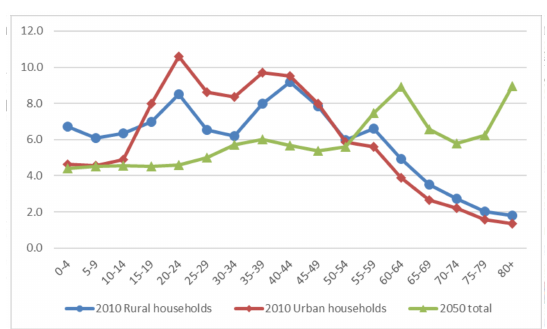
Figure 1. Shares of age groups in total population in China. Percent. Sources: UNPD [2] and NBSC [27].